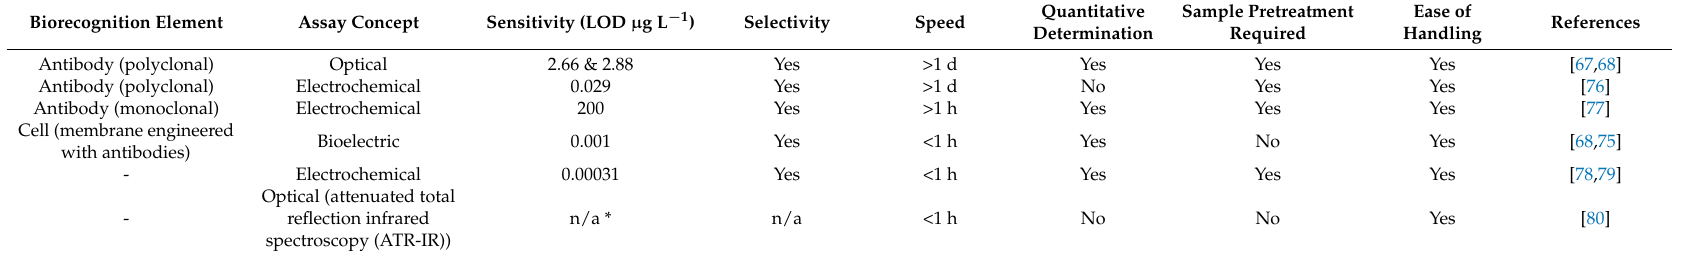
Table 2. Comparative overview of current biosensor technologies and/or concepts for the detection of 2,4,6-TCA in cork, wine and water